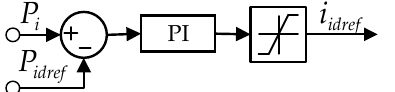
Figure 7. Control structure of the active power controller.